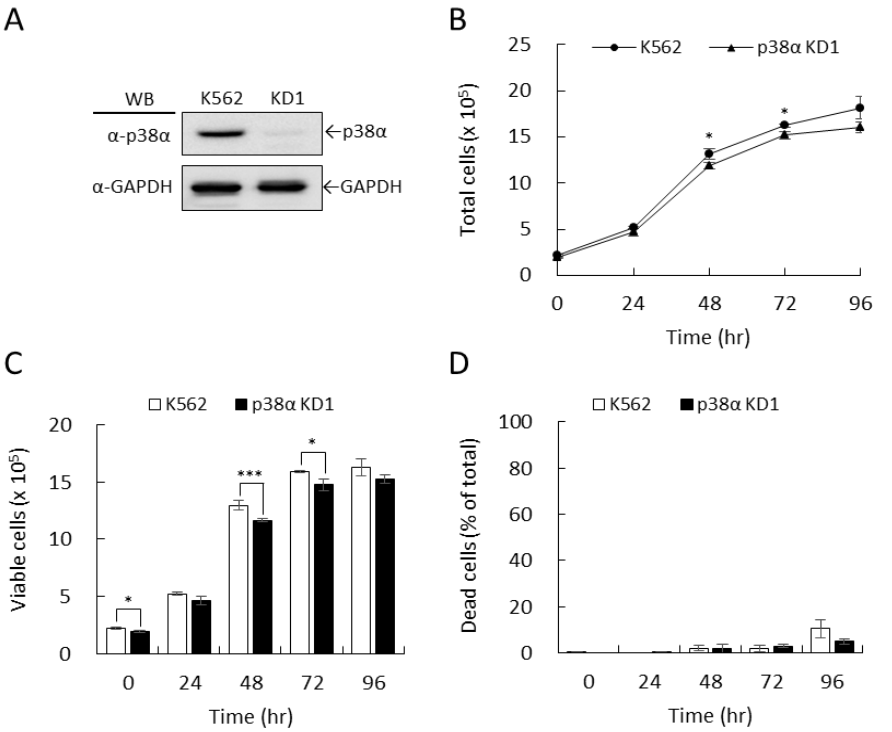
Figure 1. Knockdown of p38 α had no apparent effects on the viability of BCR-ABL-positive K562 leukemia cells. The transcripts of p38 α in K562 cells were knocked down using specific shRNAs. The protein levels of p38 α were examined by Western blotting ( A ). The cell growth of parental K562 and knockdown KD1 cell clones were examined using hemocytometer counting under a microscope ( B ). The viable ( C ) and dead cells ( D ) were identified by trypan blue exclusion. All results shown are representatives of three independent experiments. Cell number and viability are presented as the mean ± SE of three repeats. * p < 0.05, and *** p < 0.005.